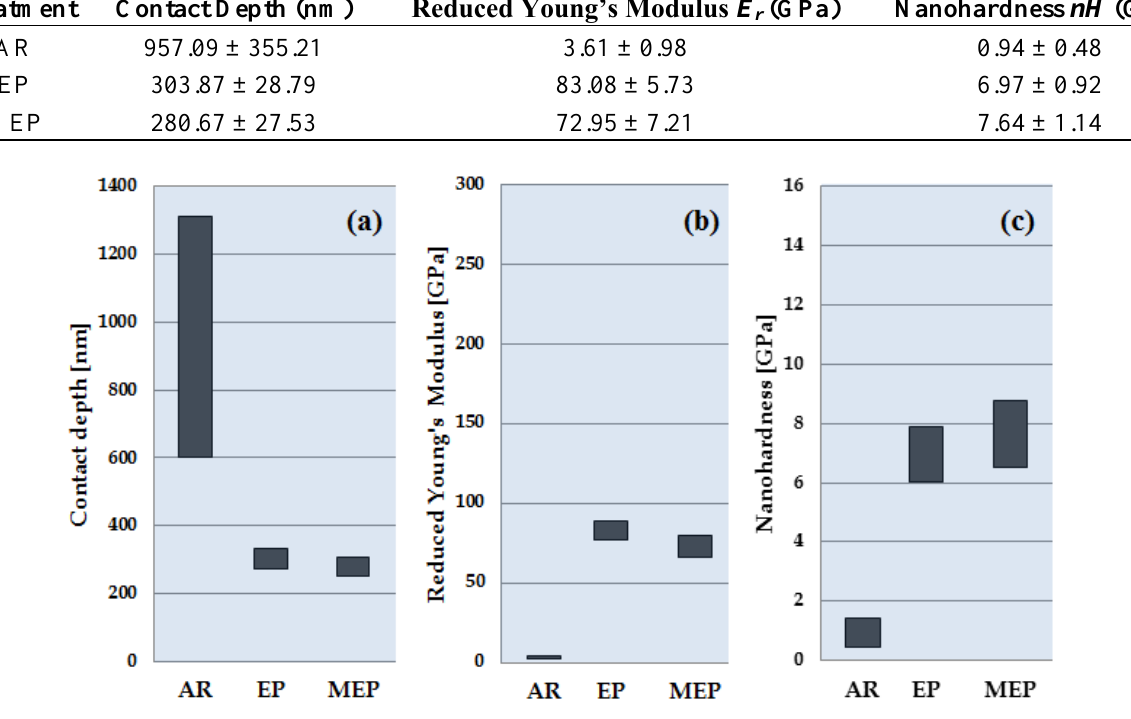
Figure 2. Nanoindentation results of TNZ alloy sample surfaces: ( a ) contact depth; ( b ) reduced Young’s modulus E r ; and ( c ) nanohardness. For the horizontal axis description, see the